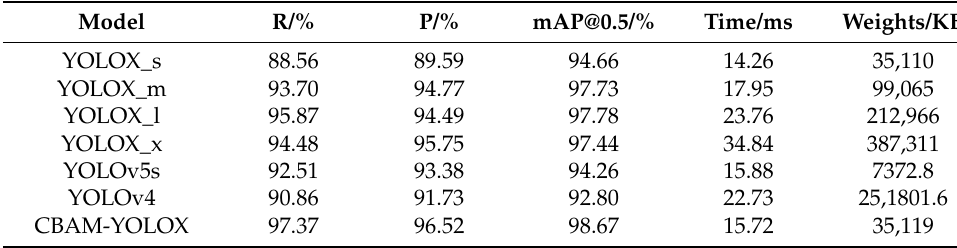
Table 3. Detection accuracy and speed of different versions of YOLOX network.